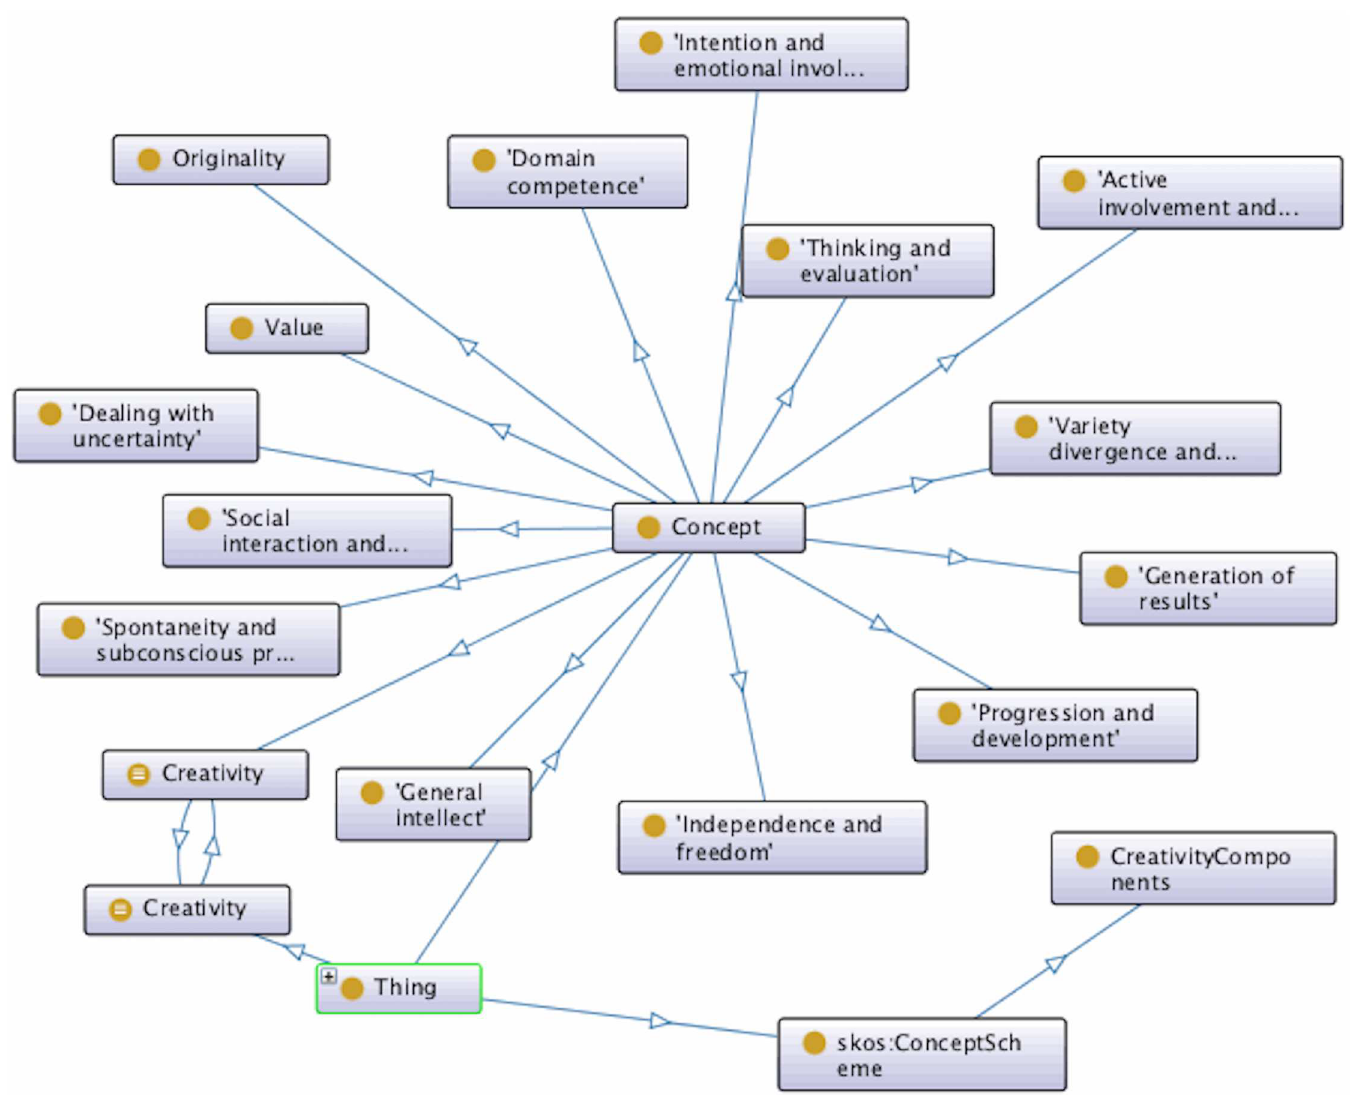
Fig 8. The ontology of creativity generated from this work’s results, in graph